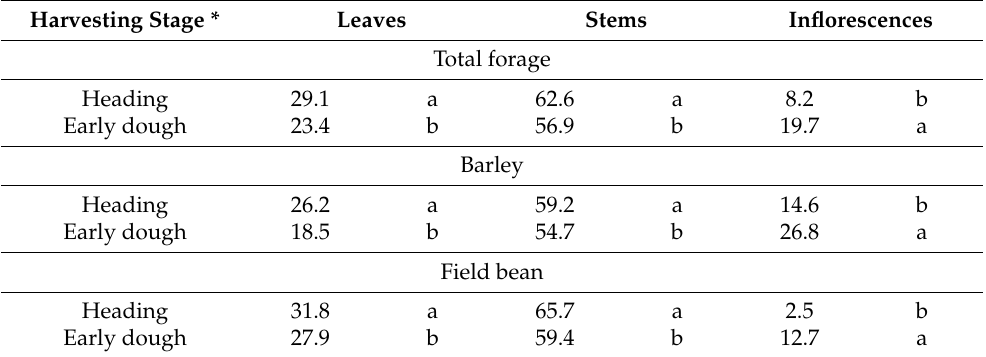
Table 5. Harvesting stage main effect on the distribution (%) of forage biomass among leaves, stems, and inflorescences of total, barley, and field bean forage.